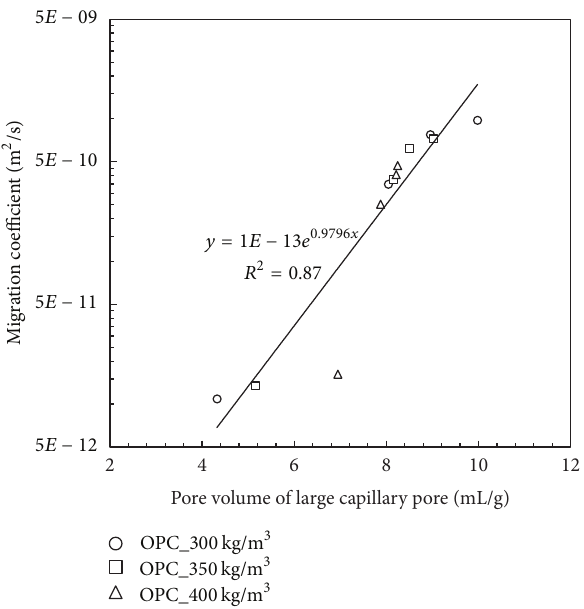
Figure 6: The relation between chloride migration coefficient and relative dynamic modulus of